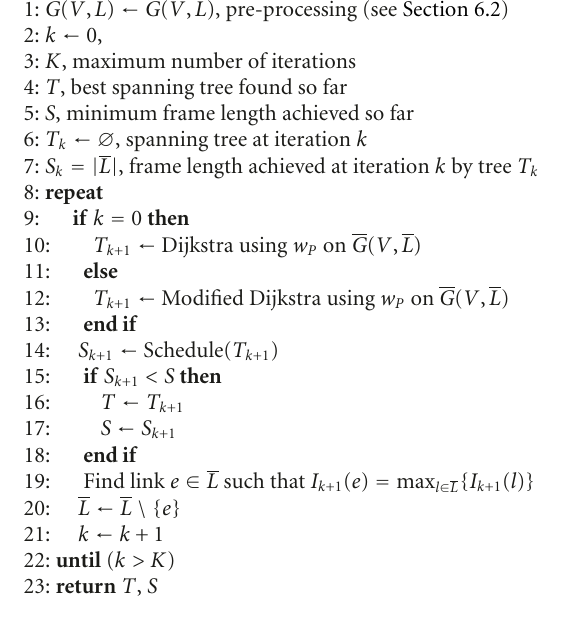
Algorithm 1: Interference aware pruning routing